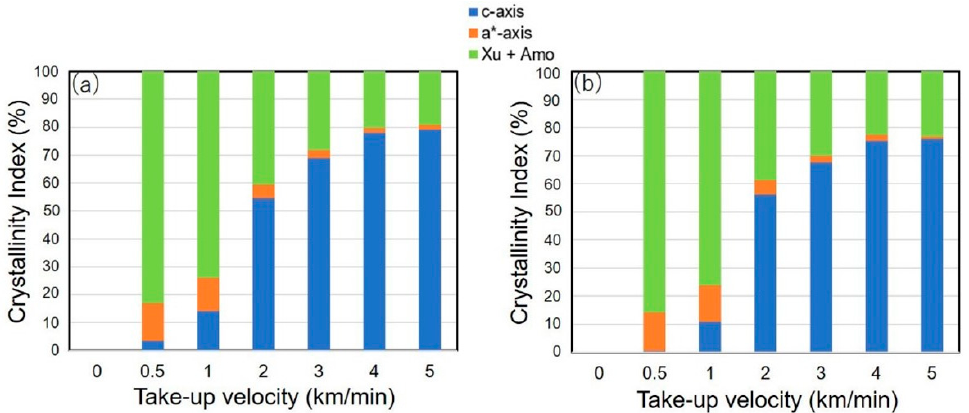
Figure 10. Changes of crystallinity index for a*-axis oriented crystals ( ■ ), c-axis oriented crystals ( ■ ) and the combined amount of unoriented crystals and amorphous phase ( ■ ) with increased take-up velocity for the fibers from ( a ) virgin and ( b ) recycled PP, melt spun at different take-up velocities.